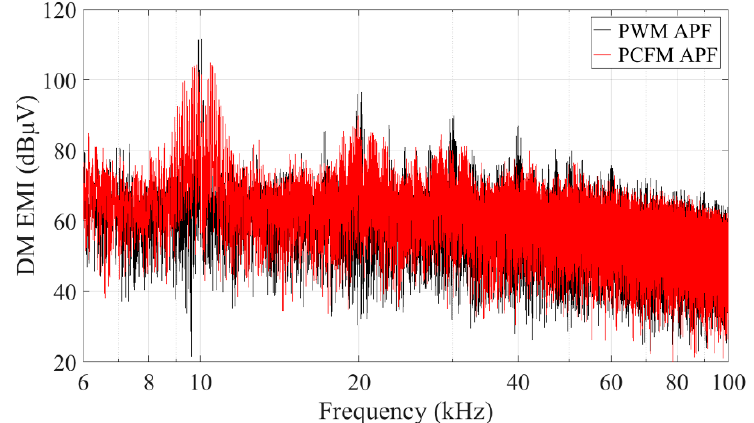
Figure 16. Experimental results of the source DM voltage v DMS spectra of APF under the nonlinear load II (Sawtooth PCFM APF with  f c = 800 Hz).